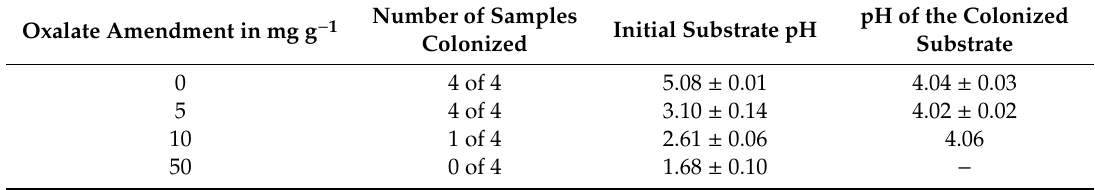
Table 2. Colonization of oxalate amended beech wood samples by agar mycelia of K. mutabilis Km 10. Oxalate Amendment in mg g − 1